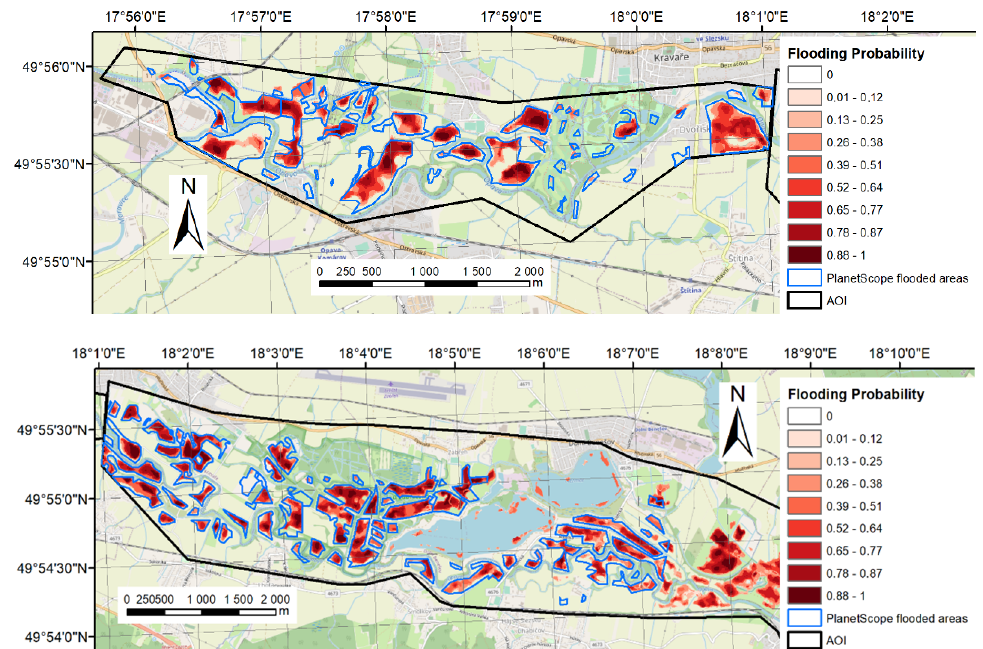
Figure 14. Flood extent detected by the developed solution (in red) from Sentinel-1 images acquired on 14 October and 15 October 2020. Manually digitized flood extent (in blue) from a Planet Scope image acquired on 15 November 2020. Sub-area 1 ( top ) and sub-area 2 ( bottom ) in the Czech Republic, autumn 2020. Source of background map: Open Street Map (OSM).